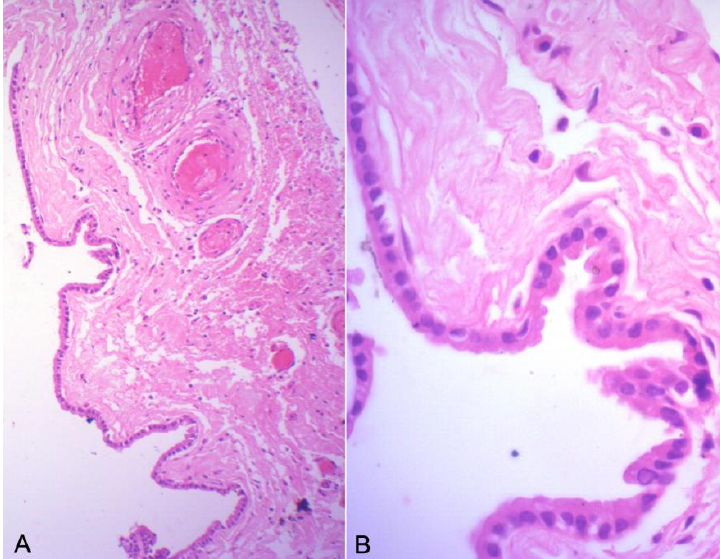
Figure 4. Histopathology shows it as a multiloculated cyst, lined by cuboidal to columnar epithelium. The walls of the locules are composed mainly of loose fibrocollagenous tissue with islands of squamous cells with keratinization, clusters of lymphocytes, hemosiderophages, adipose tissue and calcifications. Cyst had smooth muscles, arranged in two layers, and did not contain any